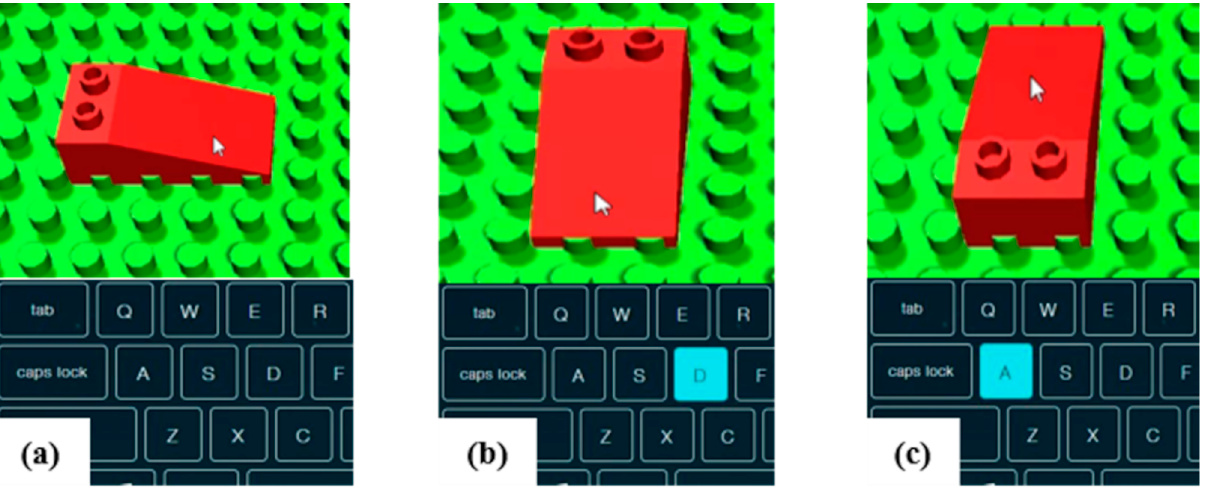
Figure 3. Picking metaphor: ( a ) the user picks a single LEGO brick to place on the plate by clicking on the appropriate GUI button; ( b ) a 3D preview of the real LEGO brick chosen appears on the GUI in the position of the mouse cursor.